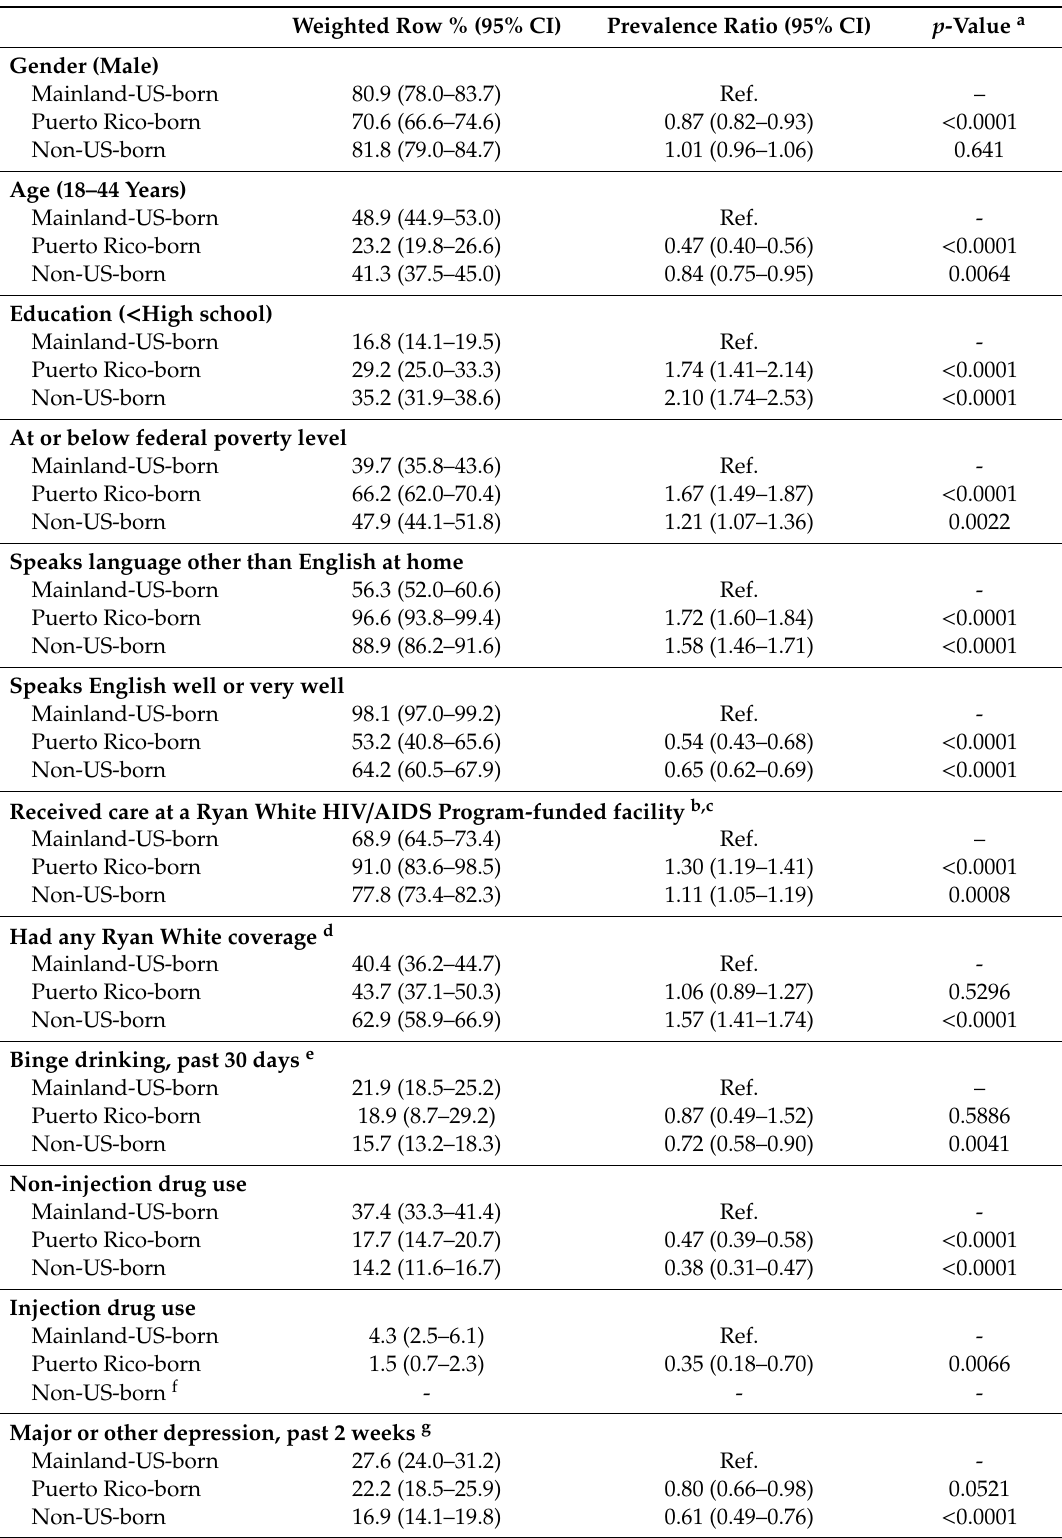
Table 2. Comparison of selected demographic, behavioral, and clinical characteristics of Hispanic / Latino adults with diagnosed HIV by place of birth, United States— Medical Monitoring Project, 2015–2018 (n =